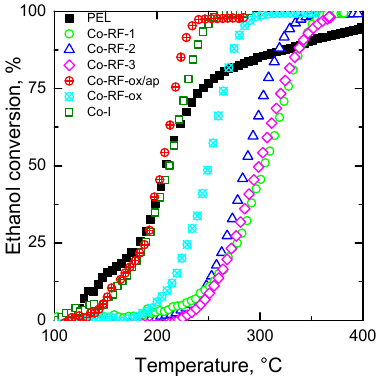
Figure 6. Dependence of ethanol conversion over the catalysts on reaction temperature. Reaction